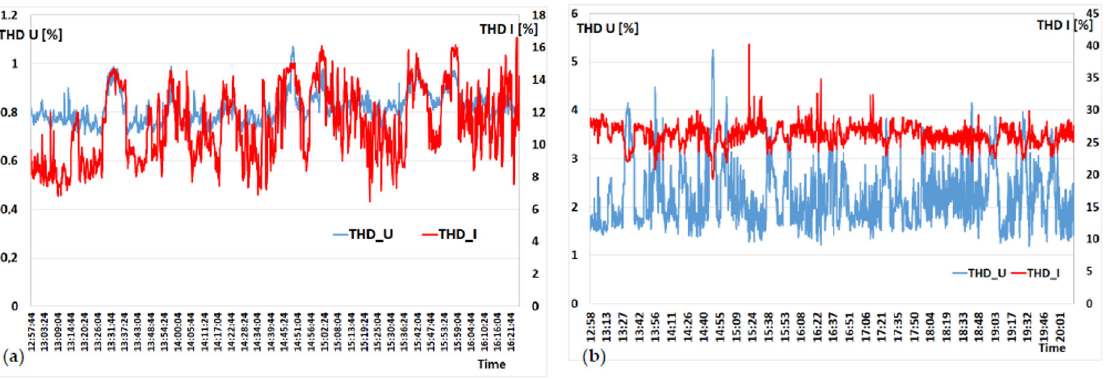
Figure 3. Changes THD_U and THD_I recorded at point A (110 kV) ( a ) and point A (cid:48) (30 kV) ( b ). Additionally, Figure 4 compares the waveforms (changes) of the THDU (a) and THDI (b) harmonic distortion coefficients measured simultaneously at point A and point A (cid:48) .